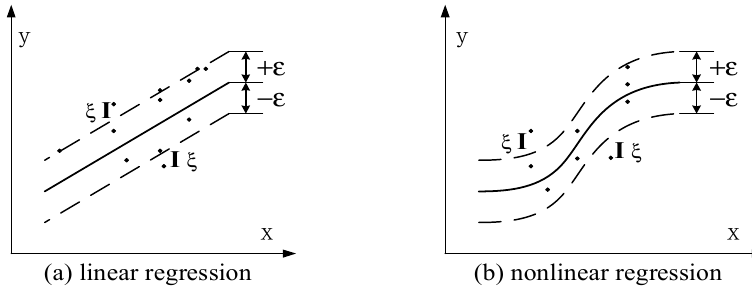
Figure 2. The overview of localization algorithm.